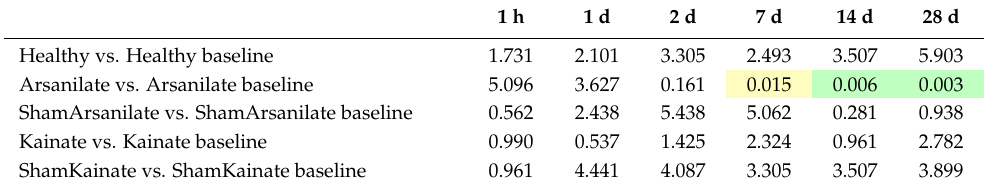
Table A8. Bonferroni-corrected p values for number of circles per minute (one-sided Wilcoxon test; p values lower than 0.05, 0.01 and 0.001 are highlighted in yellow, green and blue, respectively). 1